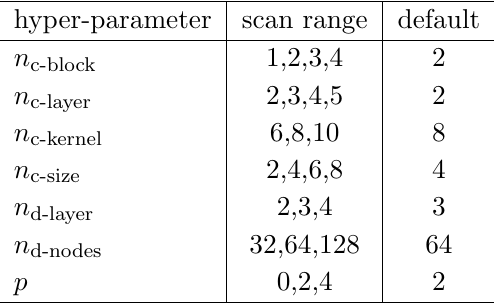
Table 1 . Range of parameters de(cid:12)ning the combined ConvNet and DNN architecture, leading to the range of e(cid:14)ciencies shown in the left panel of (cid:12)gure 3 for fully pre-processed images.